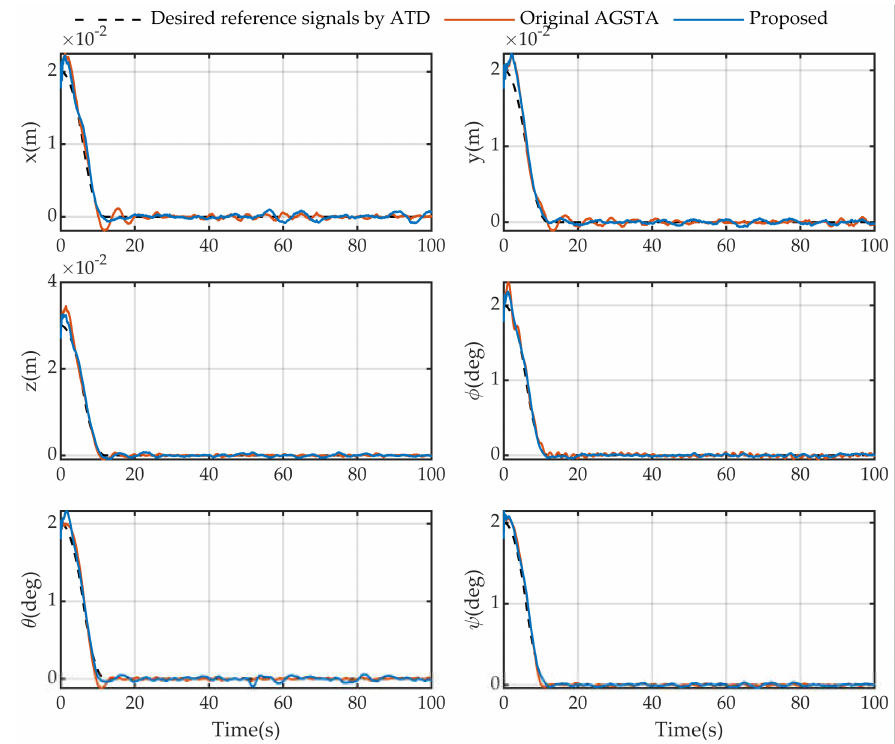
Figure 5. Time response of the vehicle state variables during station-keeping control.